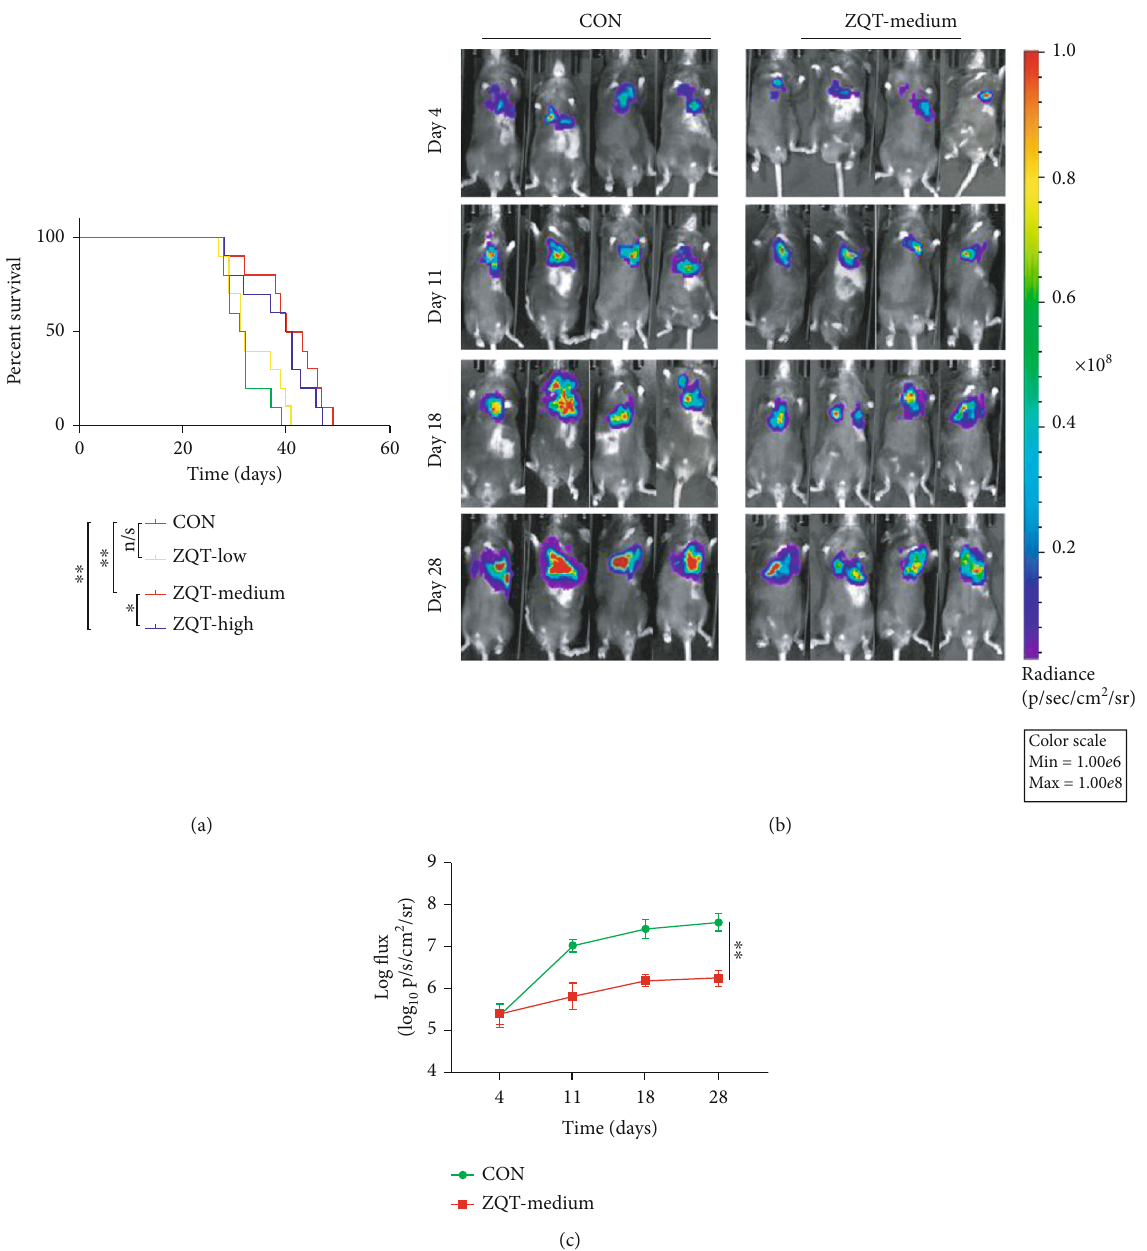
Figure 2: ZQT-medium group prolonged the survival of lung tumor-bearing mice. The C57BL/6 mice were intragastrically administered with normal saline or di ff erent doses of ZQT for 28 consecutive days after the orthotopic lung cancer mouse model was established. (a) Survival curves. (b, c) Live images taken on days 4, 11, 18, and 28, and the bioluminescence signal was recorded. n = 5 . Data are expressed as the mean ± SD . n/s: nonstatistical signi fi cance. ∗∗ p < 0 : 01 ; ∗∗∗ p < 0 : 001